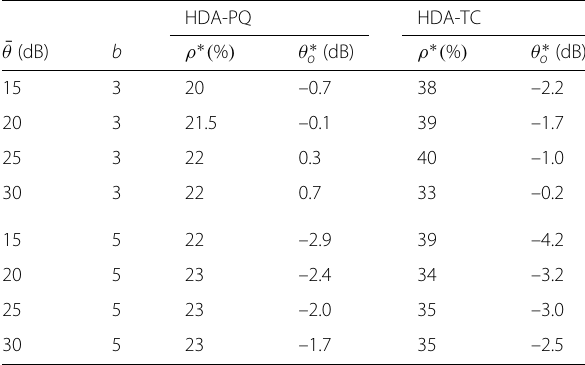
Table 4 The power allocations and outage CSNRs of HDA-PQ and HDA-TC systems shown in Fig.